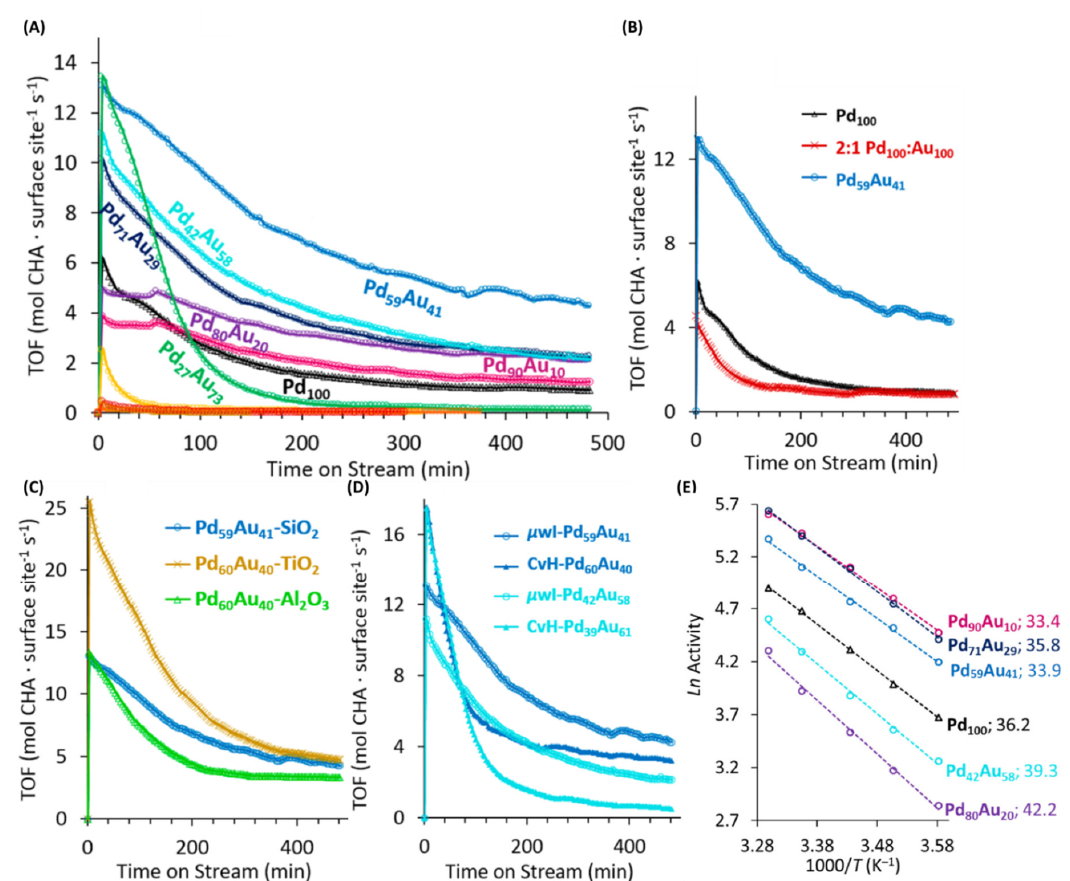
Figure 19. ( A ) Plot of TOF vs. time on stream (min) for various Pd x Au 100- x compositions; ( B ) TOF vs. time on stream curves for Pd 59 Au 41 alloy NPs, Pd 100 NPs, and physically mixed control comprising of Pd 100 and Au 100 in closely matched molar ratio; ( C ) comparative reactivity curves (TOF vs. time) for the three different supports; ( D ) reactivity curves for two most active compositions obtained using µwH and CvH; ( E ) Arrhenius activation energy plots for Pd-rich highly active Pd x Au 100- x compositions; for reference Pd 100 is shown in black. Adapted with permission from the American Chemical Society. Copyright 2016 American Chemical Society.